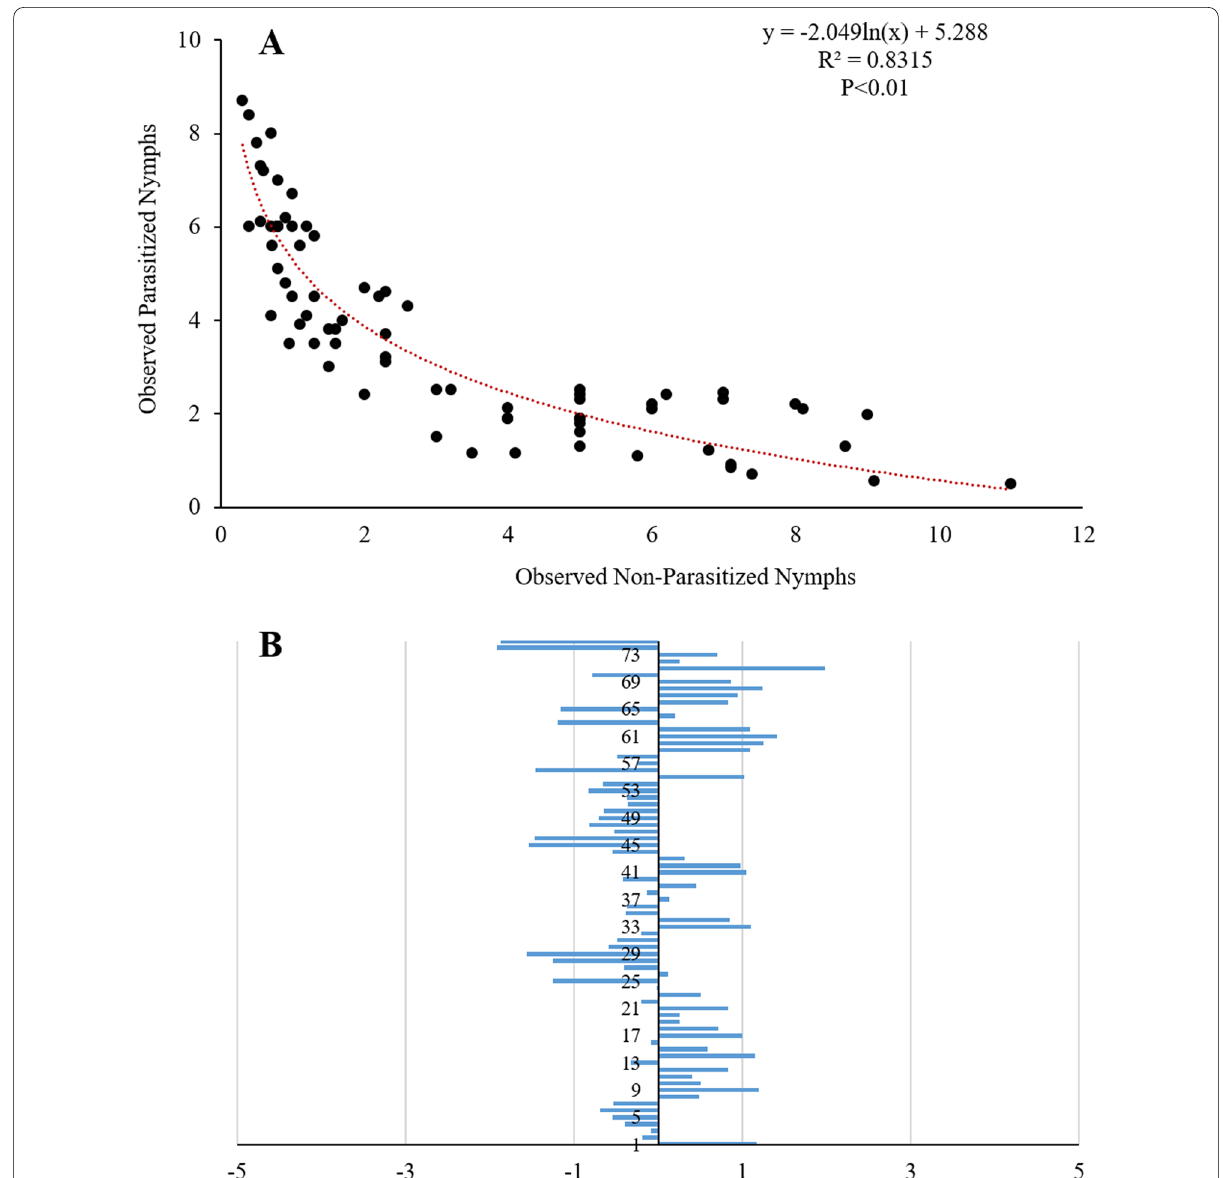
Fig. 3 a Regression analysis between parasitized and non-parasitized nymphs of Diaphorina citri observed in the study on Murraya paniculata . b Residuals in the nymph